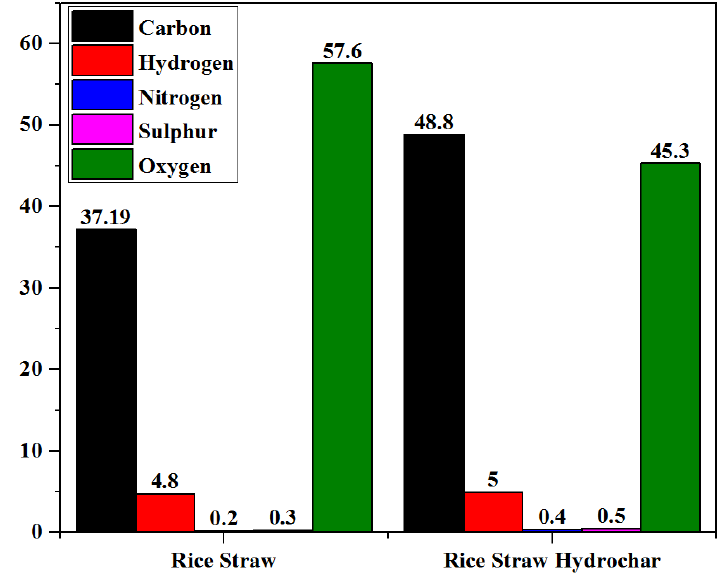
Figure 4. The ultimate analysis of rice straw and the optimized hydrochar.